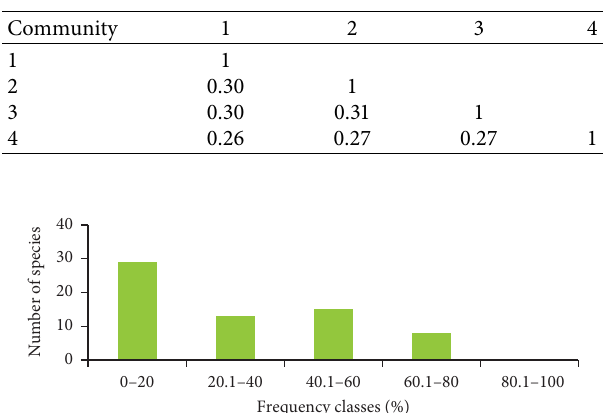
Figure 6: Frequency distributions of woody plant species in Jib Godo Natural